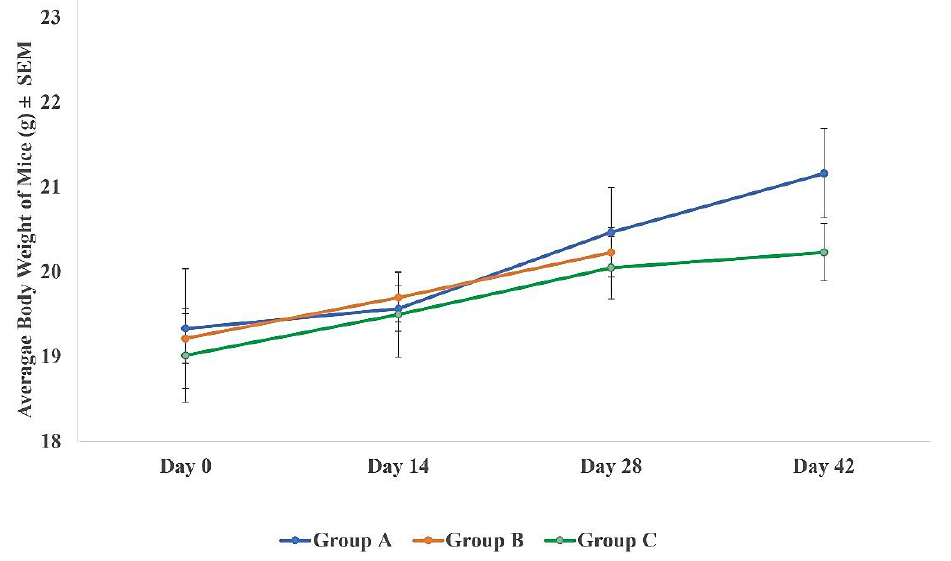
Figure 3. Average body weight of mice. Group A (control group, n = 6), Group B (unimmunised mice after ETEC challenge, n = 6), and Group C (immunised mice after ETEC challenge, n = 6). All the values are mean ± SEM. No significant difference in body weight was observed between Group A and Group C on day 0, 14, 28, and 42. All the mice in Group B died within 24 h after ETEC challenge on day 29; thus, no data were collected on day 42 in this experiment.